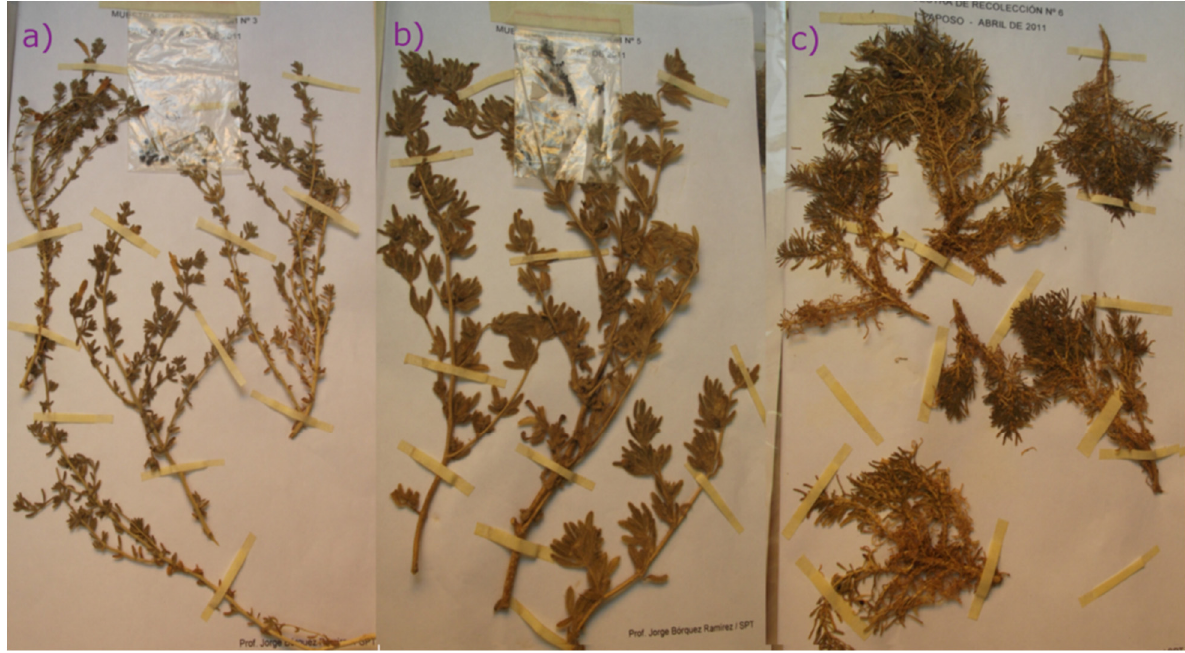
Figure 1. Pictures of herbarium specimens of ( a ) Nolana leptophylla , ( b ) N. aplocaryoides and ( c ) N. ramosissima collected in Paposo Valley, II region of